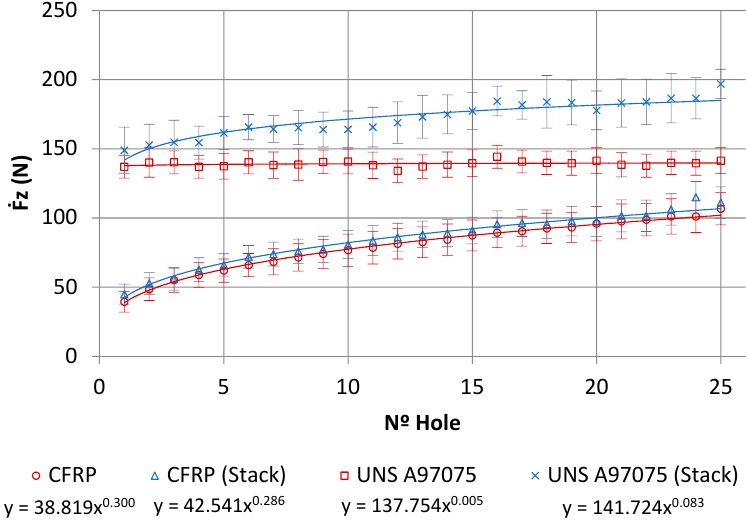
Figure 17. Axial load versus number of holes for CFRP and Al alloy plates alone and CFRP/UNS A97075 stack.